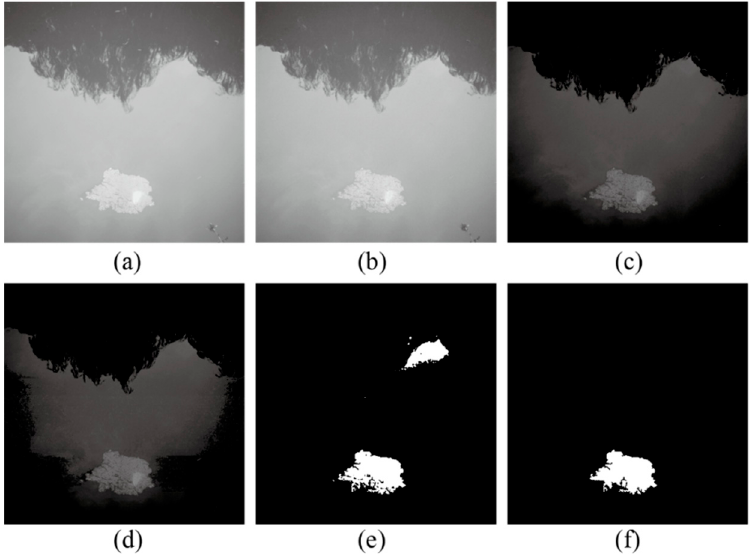
Figure 9. Segmentation result of a small target with shadows. ( a ) The original image (4000 × 4000); ( b ) the preprocessed image (500 × 500); ( c ) the result using GBS; ( d ) the result using ATE; ( e ) the segmentation result with LFTM; and ( f ) the final segmentation result.